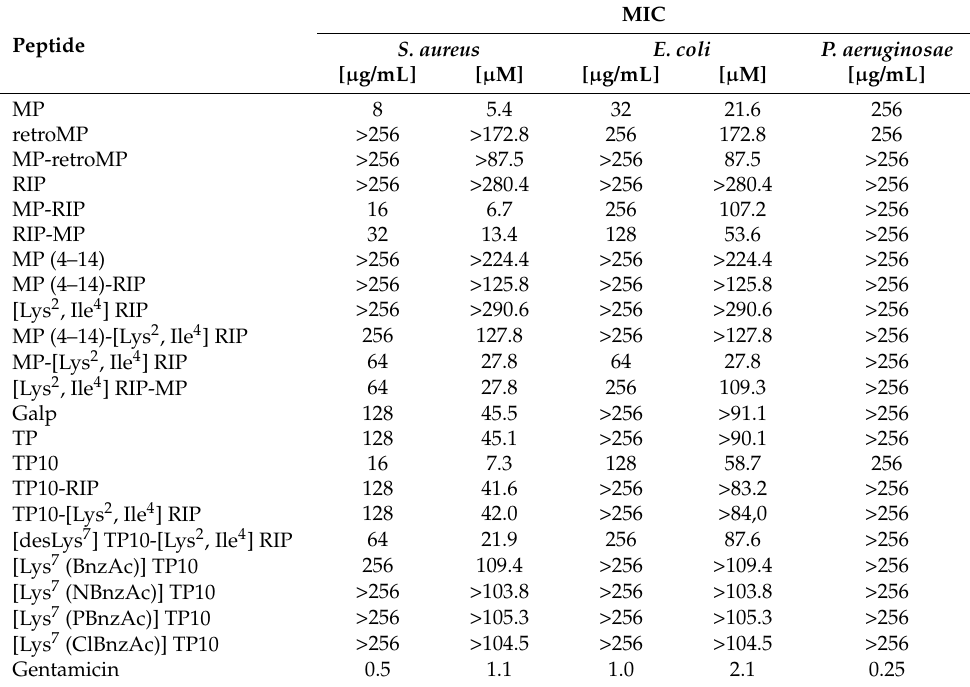
Table 3. The antimicrobial activity of synthesized peptides against three reference bacterial strains.